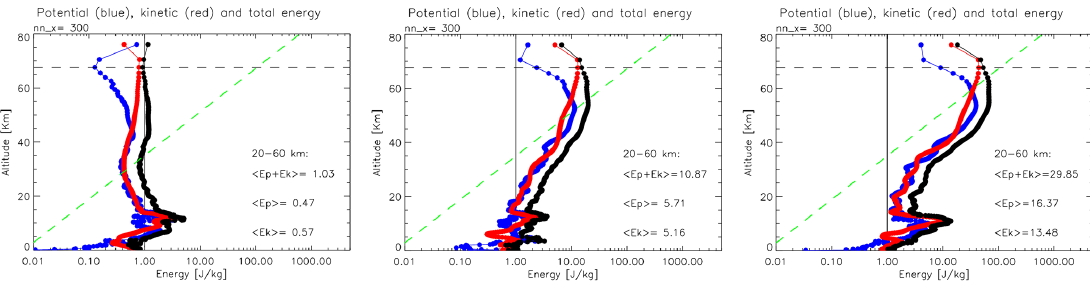
Figure 5. Spatial average of potential (blue), kinetic (red) and total (black) energy (Jkg − 1 ), calculated using Eq. (6), within a radius of 300km from storm centre, at t = 30, 50 and 70min of integration time. Vertically averaged values of total, potential and kinetic mean energy are reported in figure, in Jkg − 1 . Green dashed line represents conservative growth rate.